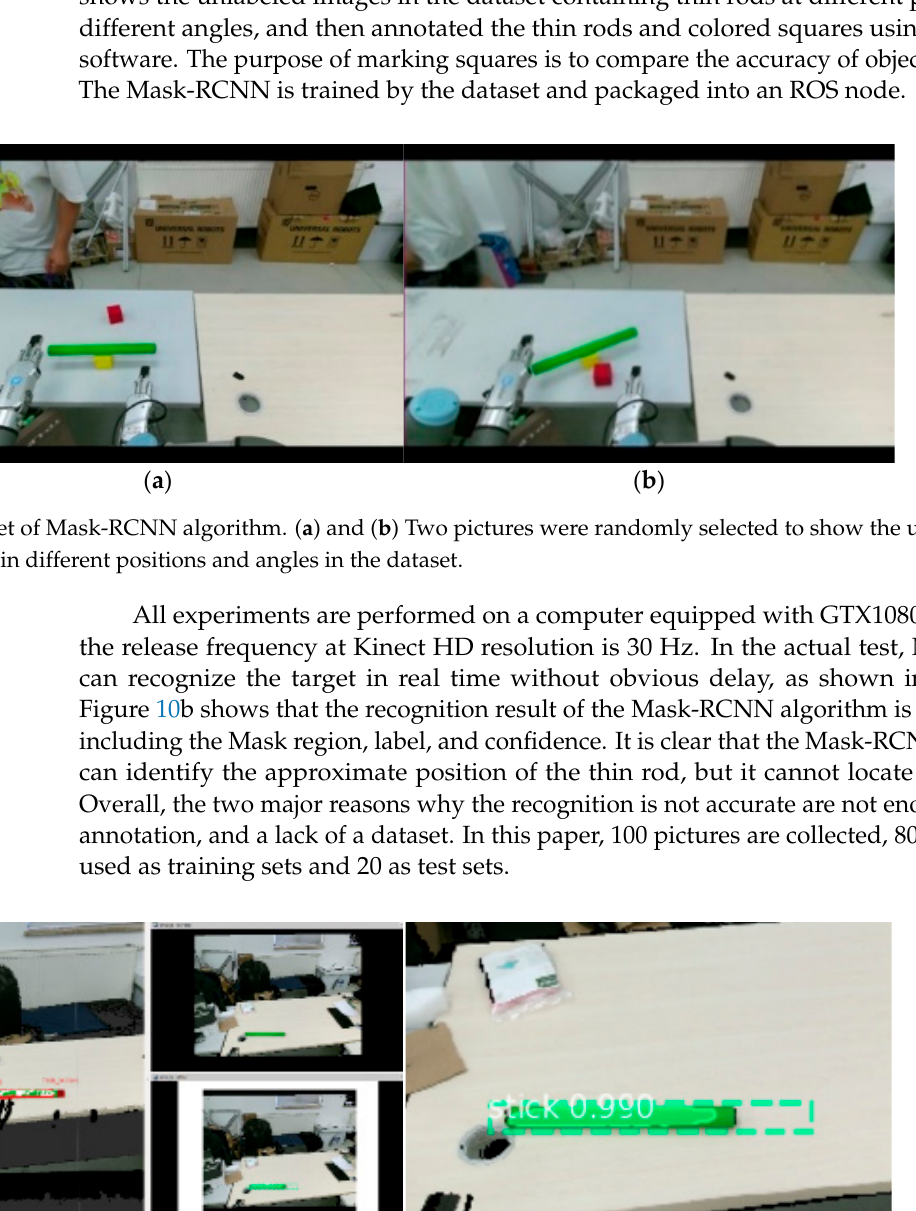
Figure 8. Renderings of Reach task of the physical robot. ( a ) The image obtained by the camera. The two triangles represent the current position of the fingers and the QR code used by Apriltags is pointed to by the arrow. ( b ) The selected target points are left and right points in the air, which are 10 cm above the QR code.